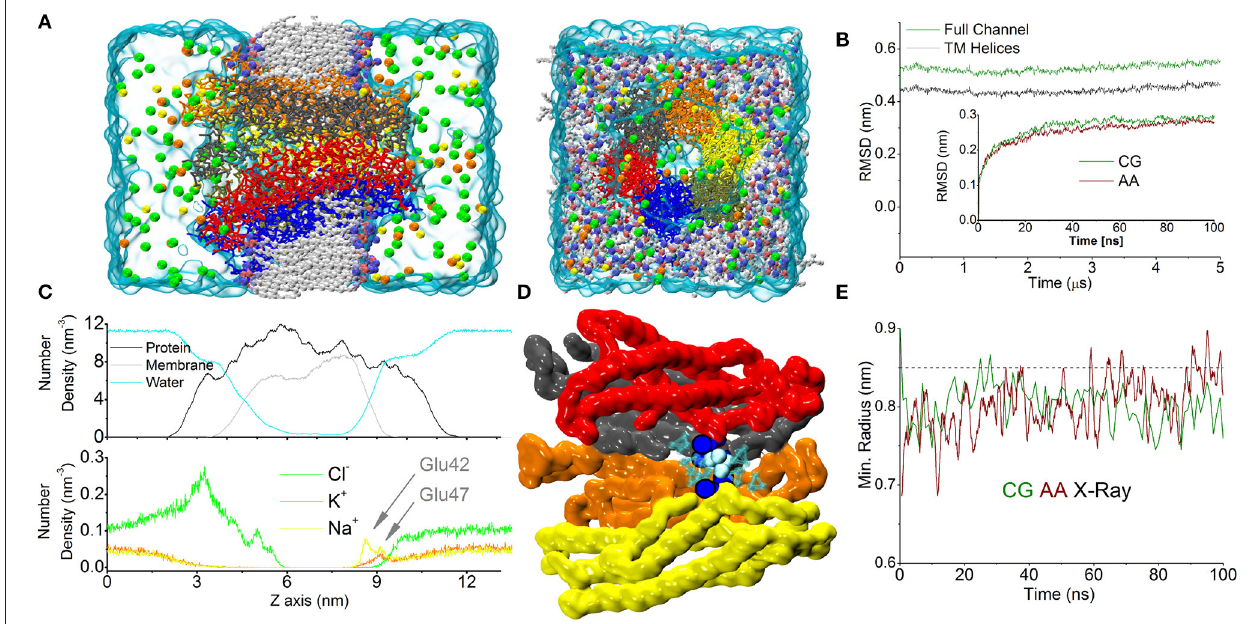
FIGURE 1 | CG simulation of the Cx26 unperturbed hemichannel. (A) Molecular representation of the CG Connexon showing the different constituents of the computational system on side and top (extracellular) views. Electrolytes are shown with their actual solvated size. Chloride, Sodium, and Potassium are shown in green, yellow, and orange, respectively. (B) RMSD calculated along the dynamics on the C α positions on the full Connexon and considering only the TM helices (dark green and black, respectively). The inset shows a comparison with the same quantity calculated from an AA trajectory during the first 100 ns of simulation reported in Zonta et al. (2015). (C) Lateral density profiles of different components of the system. Protein (black), membrane (including all beads, gray), and water (cyan) are shown in the top panel, while electrolytes are shown on the bottom to facilitate the visualization. Arrows indicate the cation’s peaks in the density profile corresponding to the position of Glu42 and 47. (D) The point of maximum constriction is found at the level of Lys41 (blue spheres), consistently with the AA simulation. In this point a single coarse-grained molecule can be accommodated (cyan spheres). (E) Plot of minimum radius vs. time at the level of the Lys41 in the first 100 ns for CG and AA simulations (green and dark red traces, respectively). The dashed line corresponds to the X-ray structure.